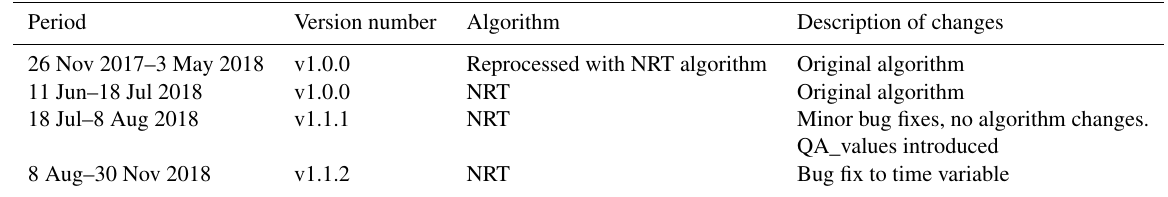
Table 2. Version numbers of TROPOMI data used in this